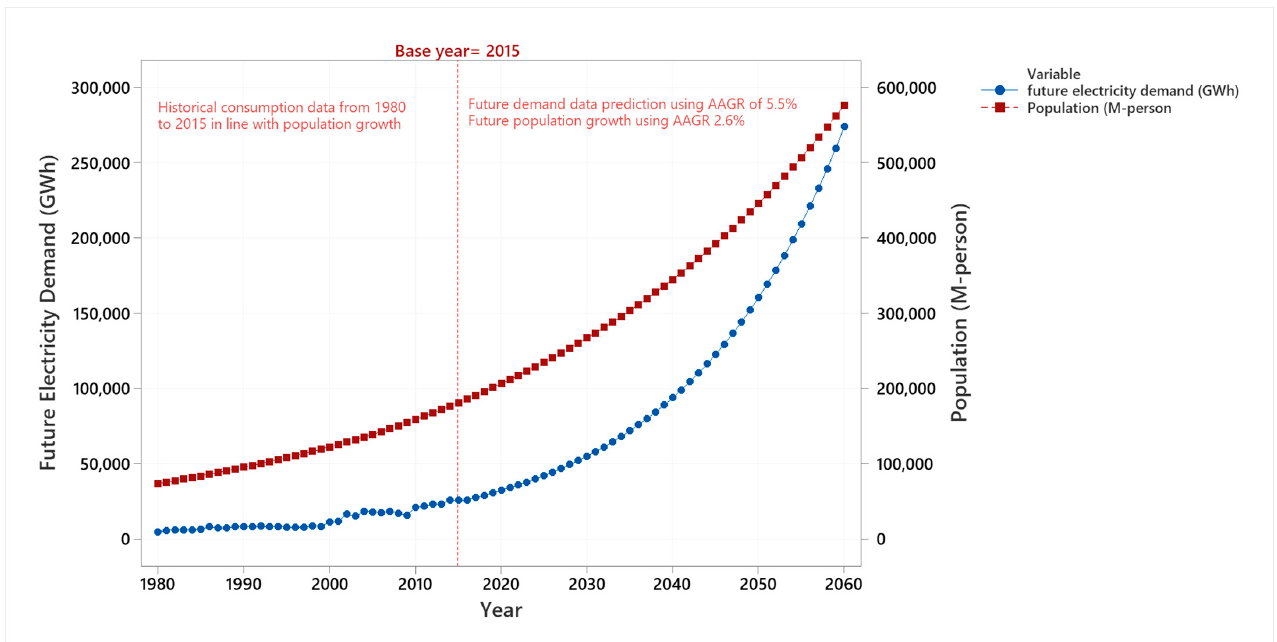
Figure 2. Prediction of future electricity demand for Nigeria from 2015 to 2060 using average annual growth rate calculated from historical data obtained from Energy Information Administration from 1980 to 2015 [24]. Table 2. Technology parameters including plant capacity factor, plant life, investment and variable cost simulated in MESSAGE code.